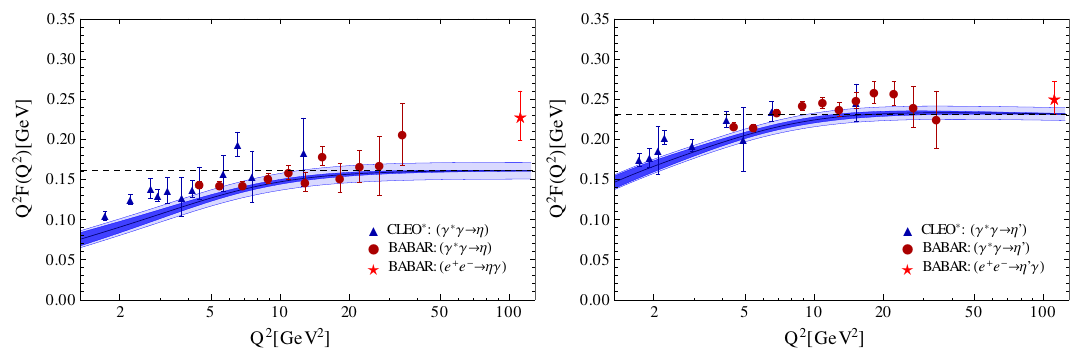
Figure 16. Predictions for the transition form factor F γγ ∗ → η ( Q 2 ) (left) and F γγ ∗ → η 0 ( Q 2 ) (right) following the approach in [12], using the decay constants determined in our work as input parame-